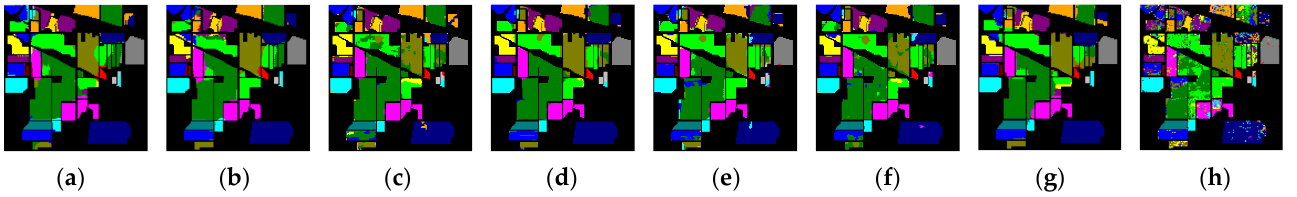
Figure 26. Classification maps using different methods on the Indian Pines dataset: ( a ) SCL – MSR: